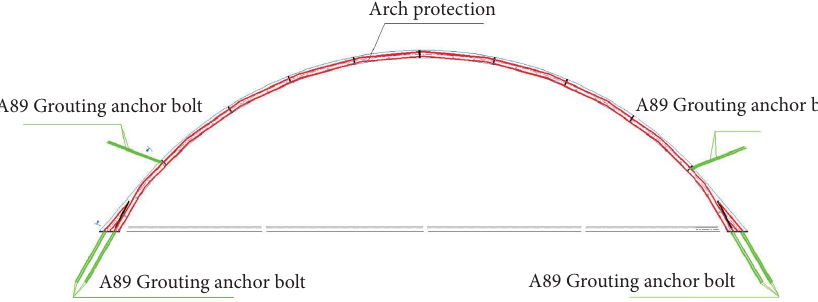
Figure 15: Schematic diagram of arch protection